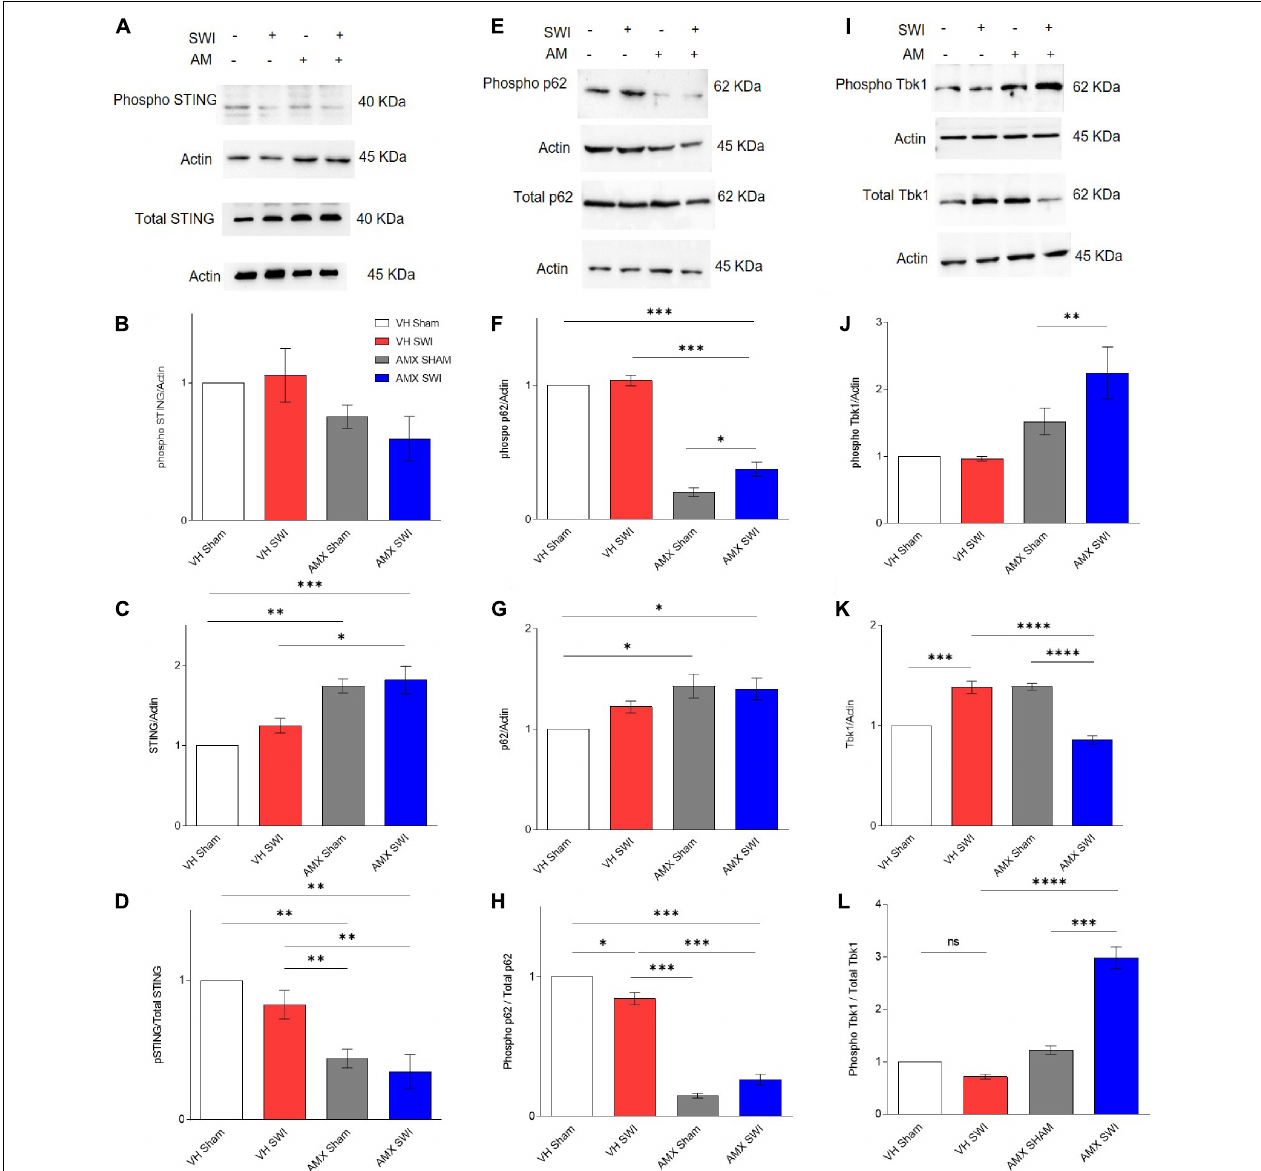
FIGURE 1 | Amlexanox (AMX) reduces the phosphorylation of Tbk1 targets STING and p62 upon Stab Wound Injury (SWI). Western blots of cortical biopsies (at 7 dpi) homogenates show trend toward decreased levels of phospho STING (A,B) but an increase in total STING levels (A,C) , resulting in a significant decrease in the fraction of phosphorylated STING (D) . Likewise, levels of phospho p62 (E,F) were significantly decreased the AMX treatment (irrespective of SWI) whereas the total amount of p62 was slightly increased (E,G) , resulting in a substantial decrease in the fraction of phosphorylated p62 in the overall p62 pool (H) . Levels of phosphorylated Tbk1 were strongly increased in AMX-SWI samples (I,J) whereas total levels of Tbk1 were reduced in these samples (but slightly increased by AMX or SWI alone) (K) , resulting in a massive increase in the fraction of phosphorylated Tbk1 in the Tbk1 pool in AMX-SWI samples (L) . n = 3 animals/group. Average ± SEM; one-way ANOVA ns: not significant, ∗ p < 0.05, ∗∗ p < 0.01, ∗∗∗ p < 0.001, ∗∗∗∗ p < 0.0001; full statistical report in Supplementary Table 3 ; original full uncropped WB in Supplementary File 1